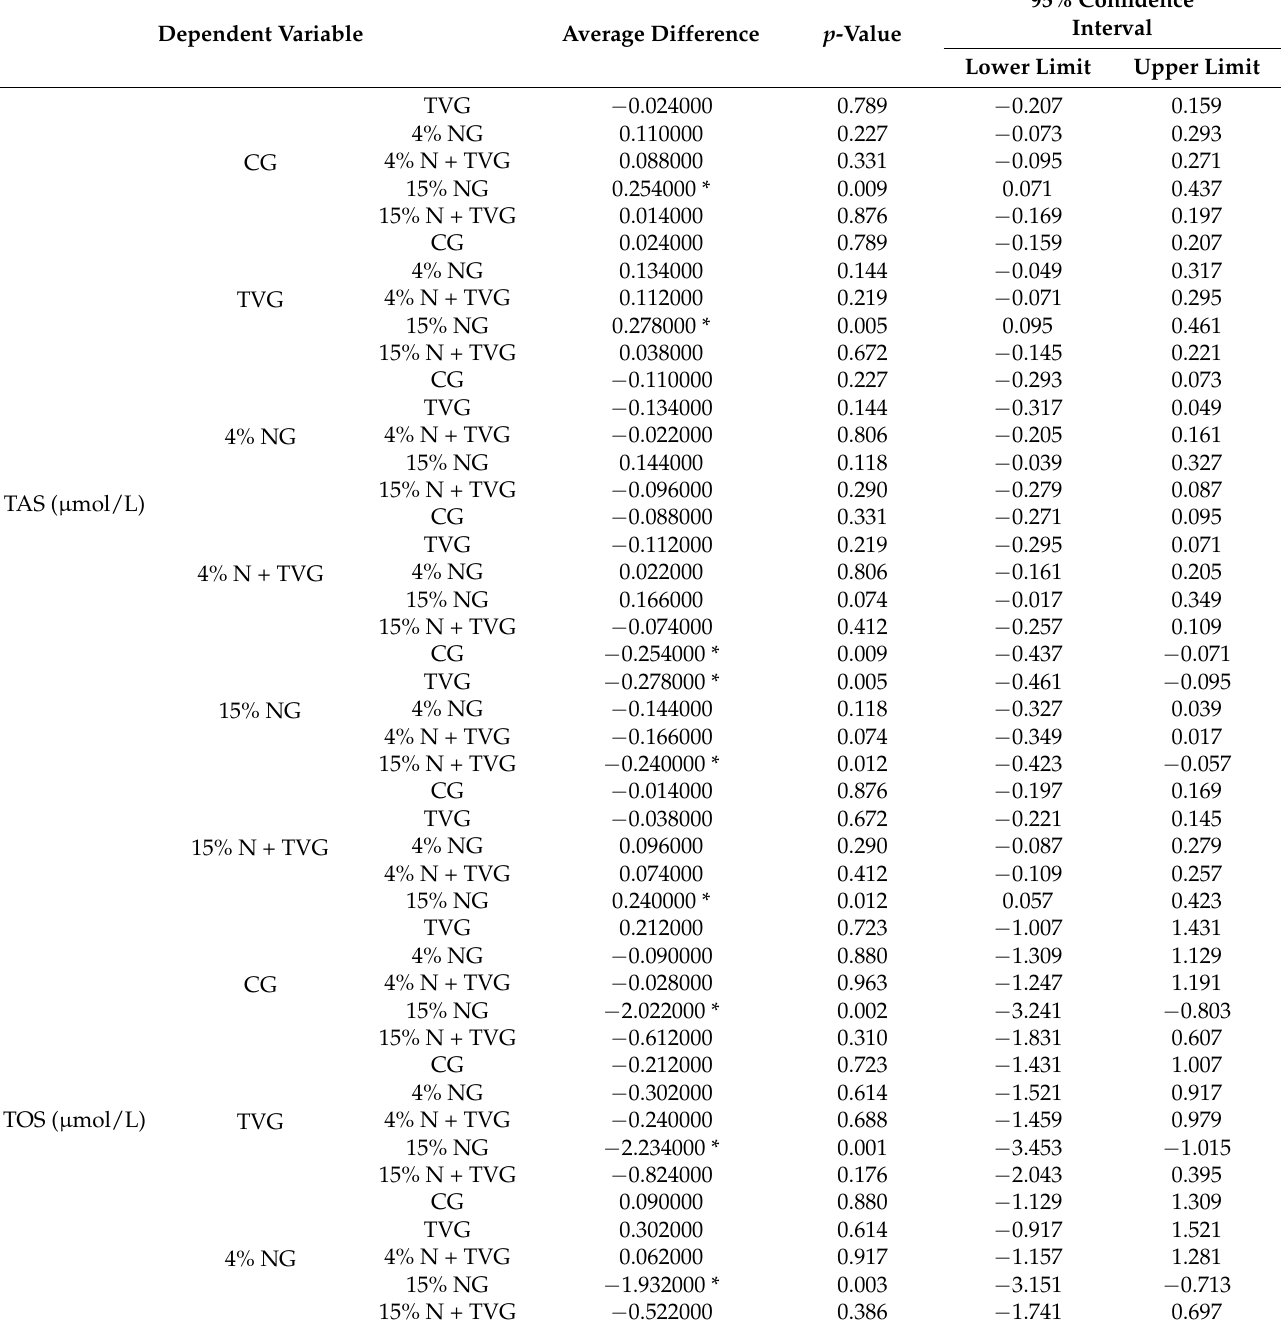
Table 2. Statistical analysis of biochemical results between